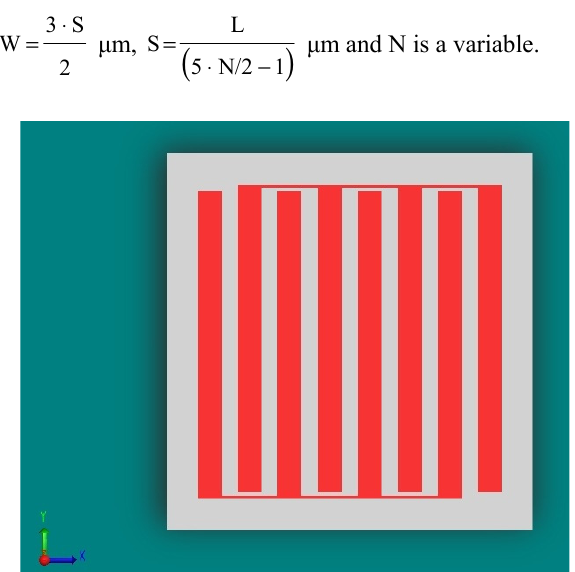
Fig. 6: Top view of a structural model of 8 electrodes in a planar interdigitated array. The size is 1000×1000 μ m, the width W and finger spacing S of the electrodes in this figure are 79 μ m and 52 μ m, respectively.